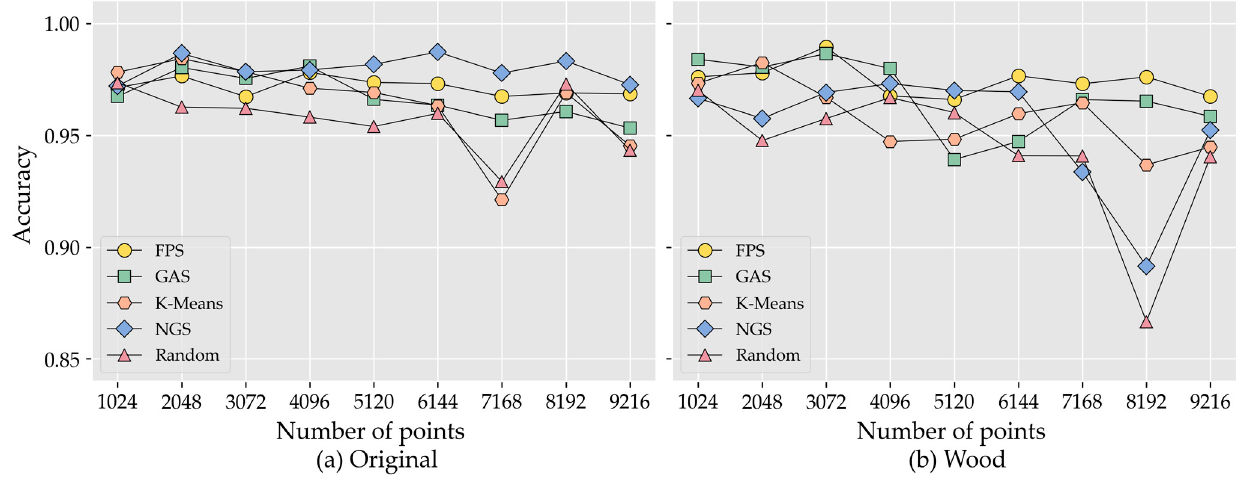
Figure 9. Accuracy curves of tree species classification for five downsampling methods using different sampling points: ( a ) point cloud data without leaf and wood separation; ( b ) point cloud data of the wood.